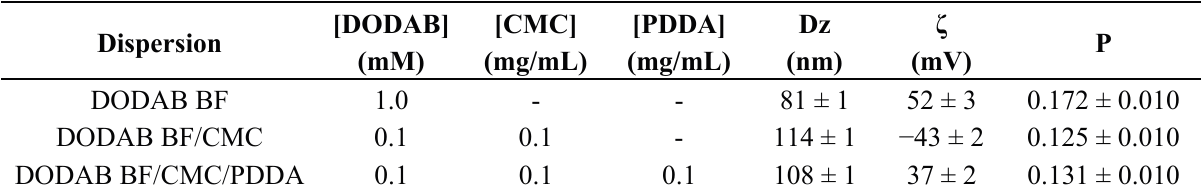
Table 1. Zeta-average diameter (Dz), zeta-potential ( ζ ) and polydispersity (P) of dioctadecyldimethylammonium bromide (DODAB) bilayer fragments (BFs), DODAB BF/carboxymethylcellulose (CMC) and DODAB BF/CMC/poly(diallyldimethylammonium) chloride (PDDA) assemblies or